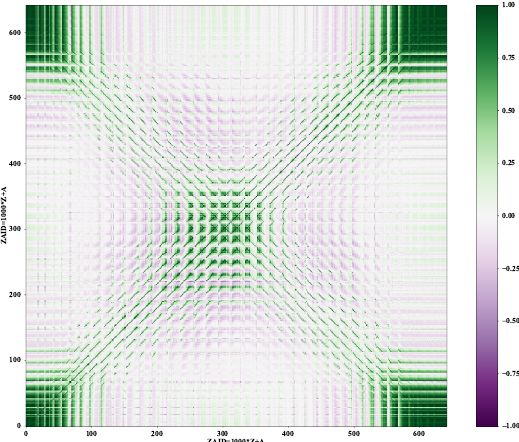
Figure 4. Correlation matrix between the cumulative fission product yields for 252 Cf(sf) using the fit to experimental data from EXFOR. Indices are ordered by increasing ZAID = 1000 × Z + A but do not correspond one-to-one to the numbers on the axes.